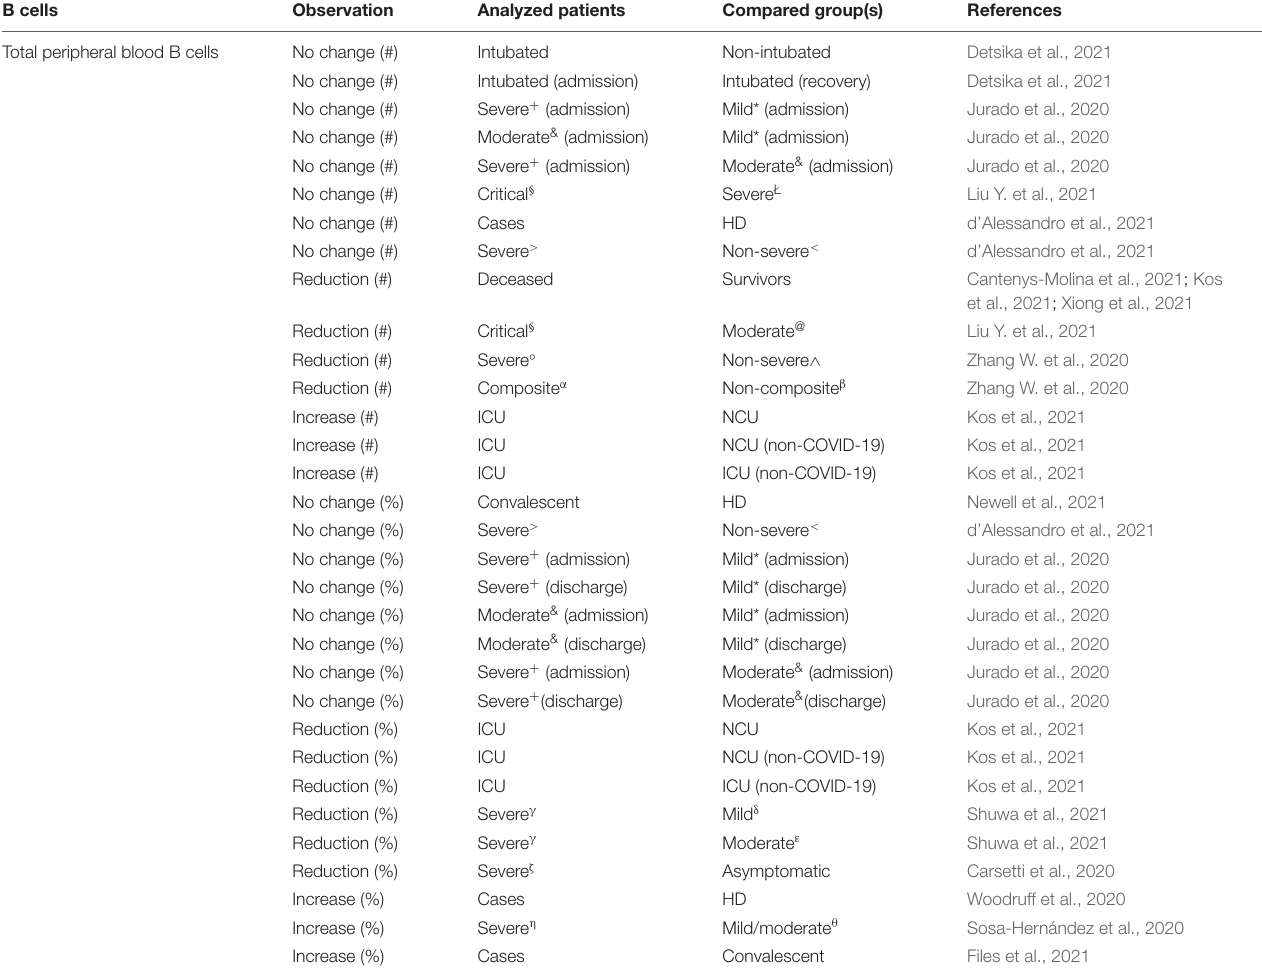
TABLE 5 | Observed fluctuation in B cells in adult COVID-19 patients. B